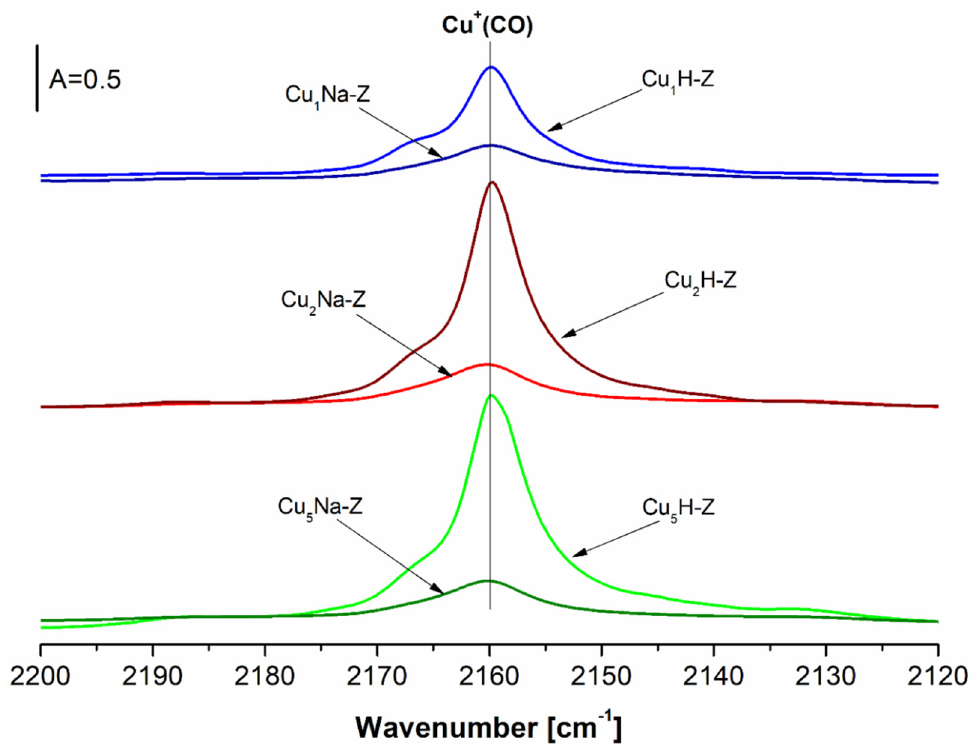
Figure 7. IR spectra of CO adsorbed at 25 °C on the surface of Cu-zeolite samples. The data obtained for the zeolites pretreated with NaNO 3 and then modified with Cu (Cu x Na-Z) indicated low concentration of Cu + (ca 30 µ mol/g), independent on the copper the drastic deterioration of exchange capacity of such modified